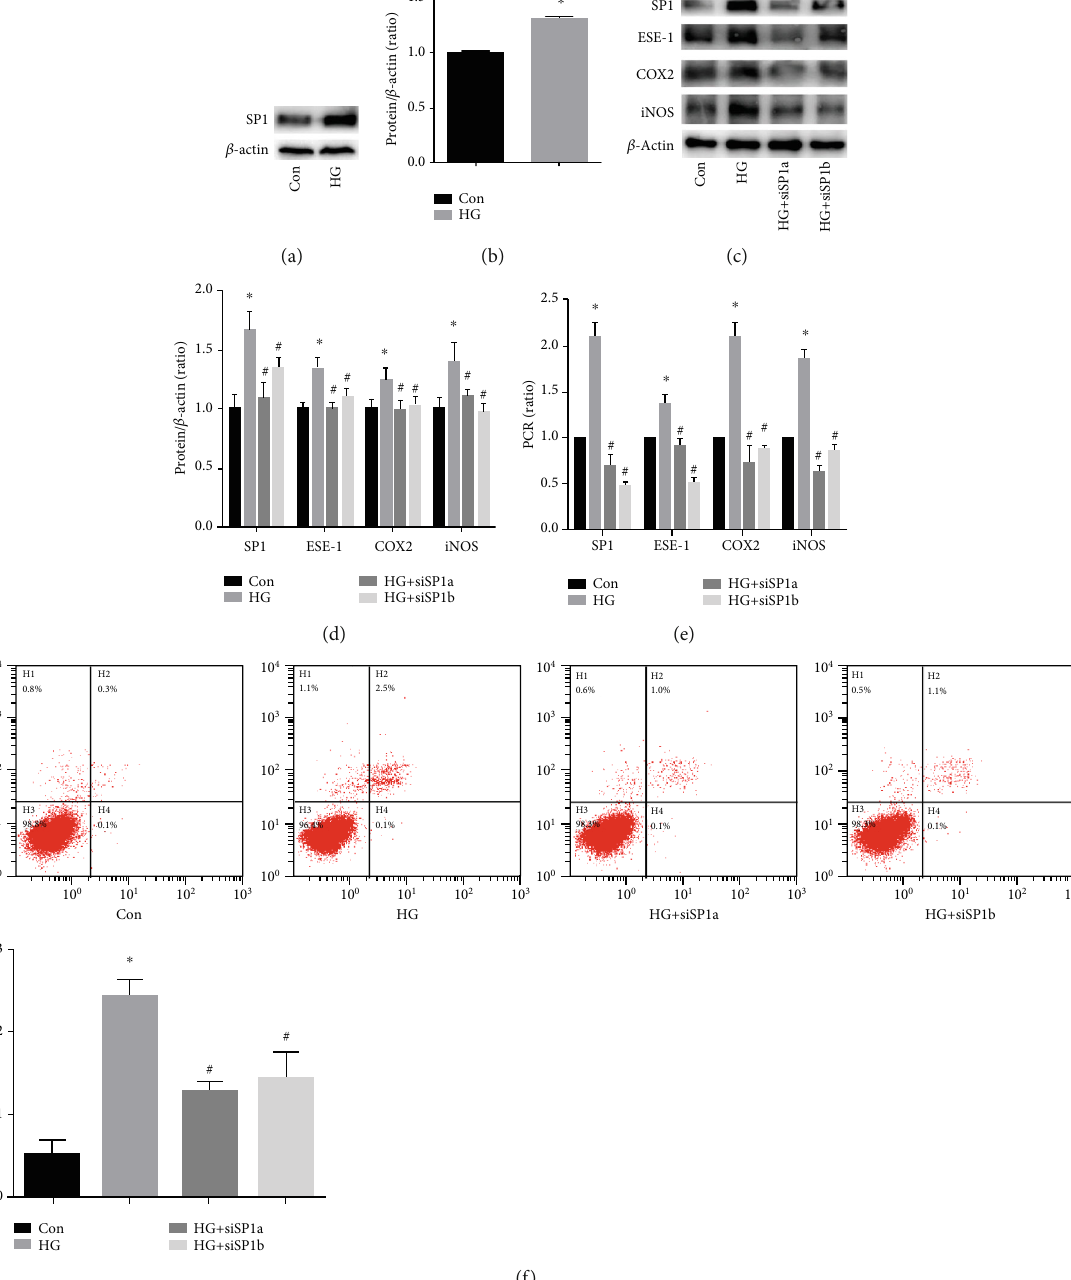
Figure 5: Speci fi city protein 1 (SP1) downregulation counteracted high glucose-induced E26 transformation-speci fi c sequence transcription factor-1 (ESE-1) expression and endothelial apoptosis. (a, b) Western blot analysis of SP1 in HUVECs cultured under normal or high glucose conditions. Compared with the control group, high glucose treatment increased SP1 protein expression in HUVECs. (c, d) Western blot analysis of SP1, ESE-1, cyclooxygenase 2 (COX2), and inducible nitric oxide synthase (iNOS) in HUVECs with siSP1 under high glucose conditions. siSP1 decreased ESE-1, iNOS, and COX2 protein expression in hyperglycaemic HUVECs. (e) qPCR analysis of SP1, ESE-1, iNOS, and COX2 in HUVECs with siSP1 under high glucose conditions. siSP1 decreased ESE-1, iNOS, and COX2 mRNA expression in hyperglycaemic HUVECs. (f) The e ff ects of siSP1 on high glucose-mediated apoptosis in HUVECs. siSP1 decreased cell apoptosis in hyperglycaemic HUVECs. siSP1: small interfering RNA SP1. ∗ P < 0 : 05 , compared with the control group; # P < 0 : 05 , compared with high glucose